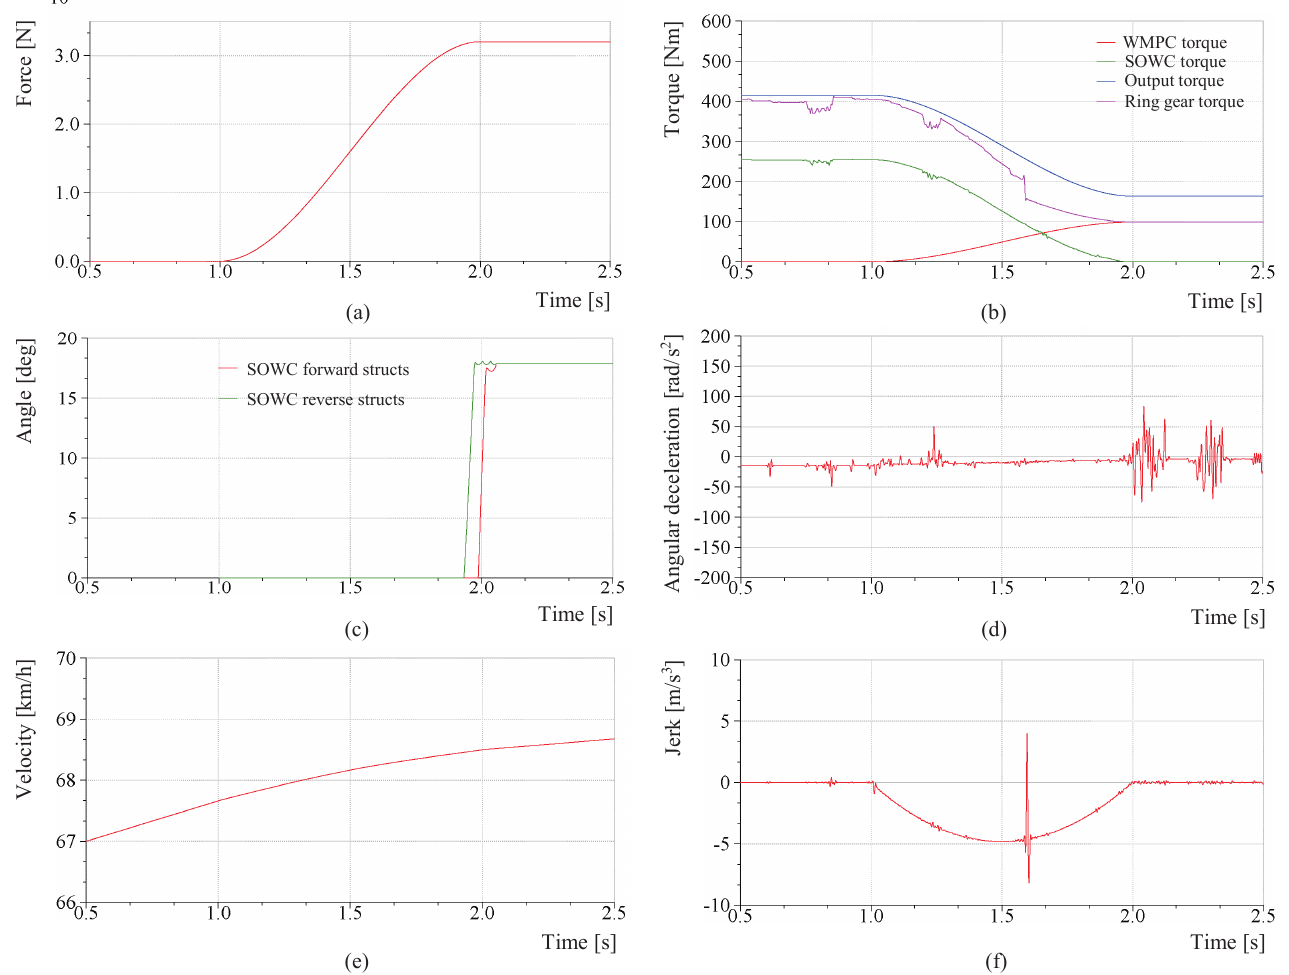
Figure 12. Simulation results of the upshifting process: ( a ) Changes of WMPC pressing force. ( b ) Changes in torque transmitted by each component. ( c ) Changes of struts rotation angle. ( d ) Changes of ring gear angular deceleration. ( e ) Changes in vehicle speed. ( f ) Changes in